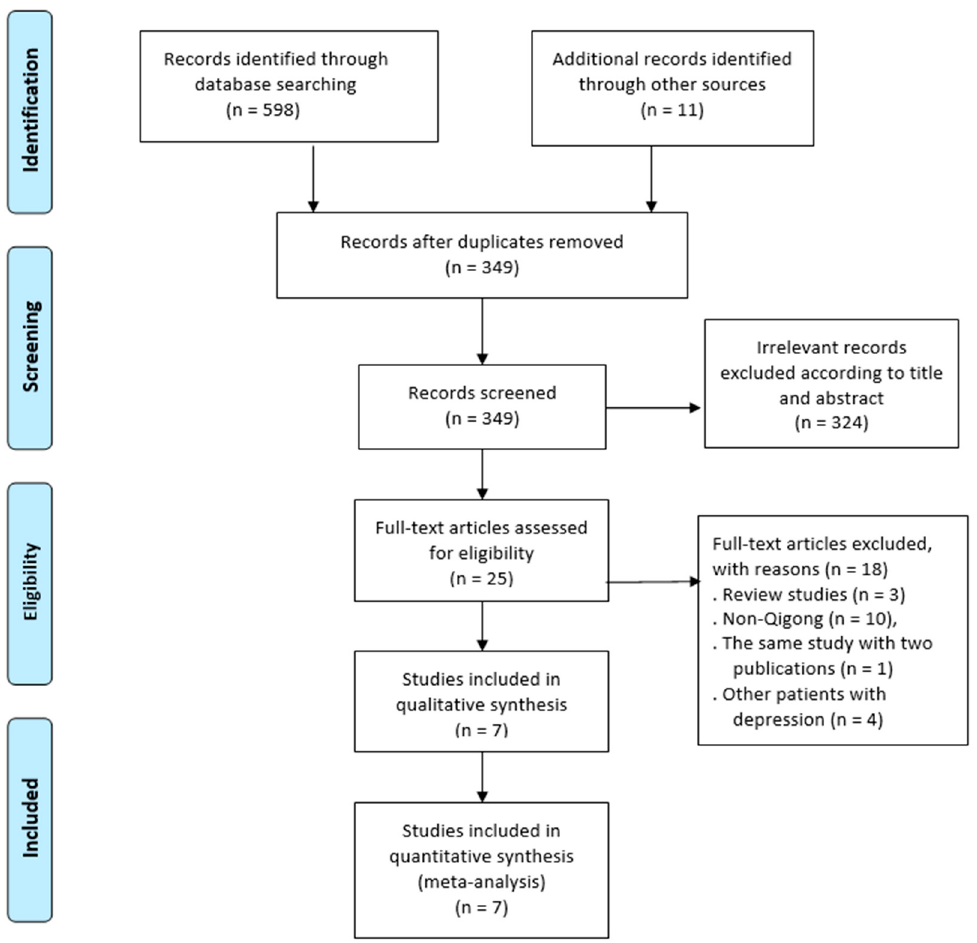
Figure 1. The process of study identification, screening, and selection.